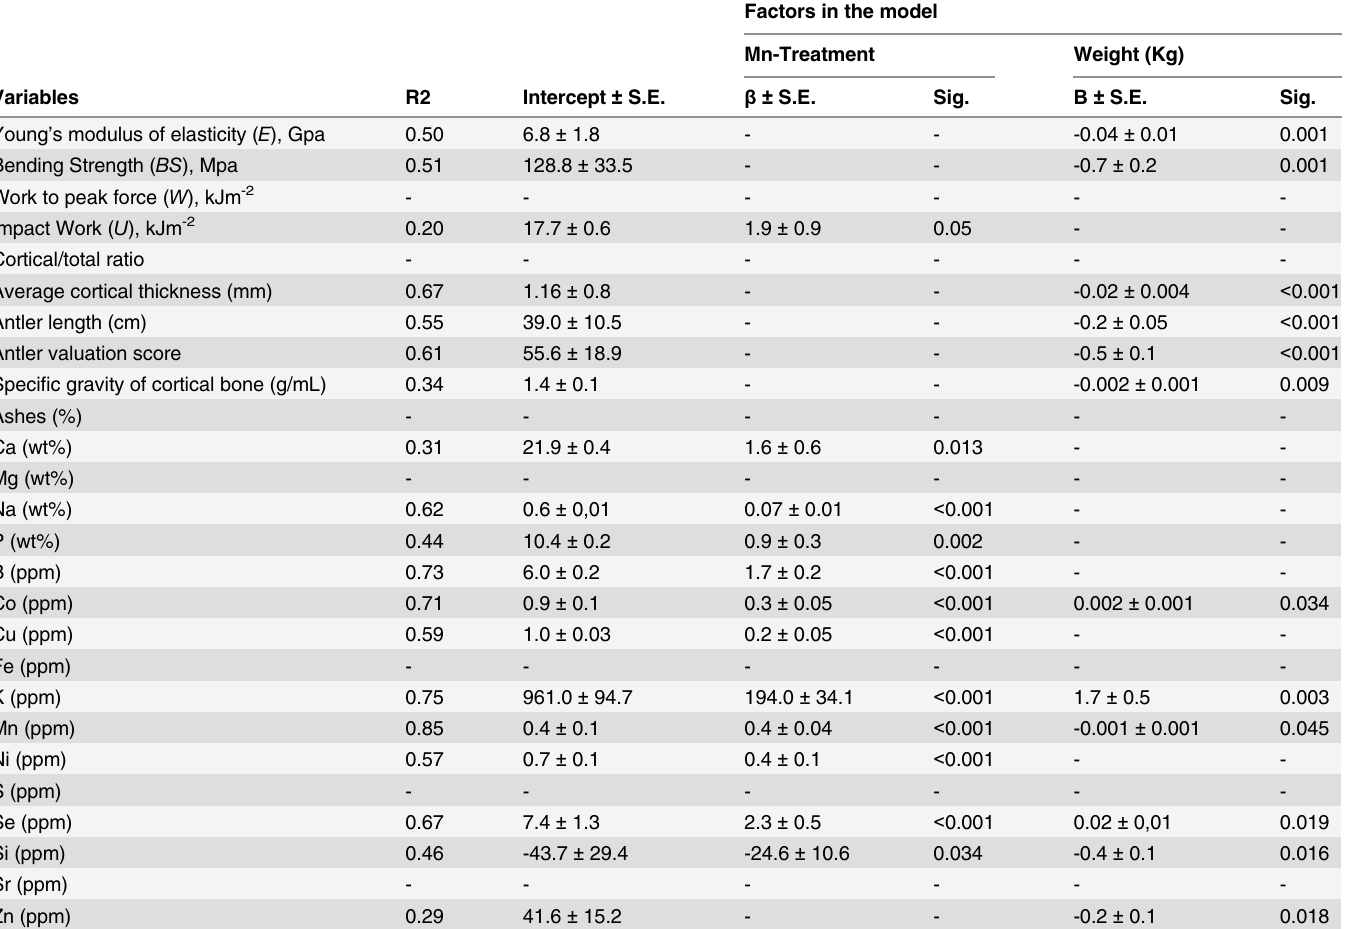
Table 2. General Linear Model analyses showing the influence of treatment (injections of Manganese) and weight, on the composition, structure and mechanical properties of antlers in adult red deer. The coefficient β ( ± S.E.) is related to the difference of the value observed in animals that were injected with respect to the group not injected. Dashes indicate coefficients that were not